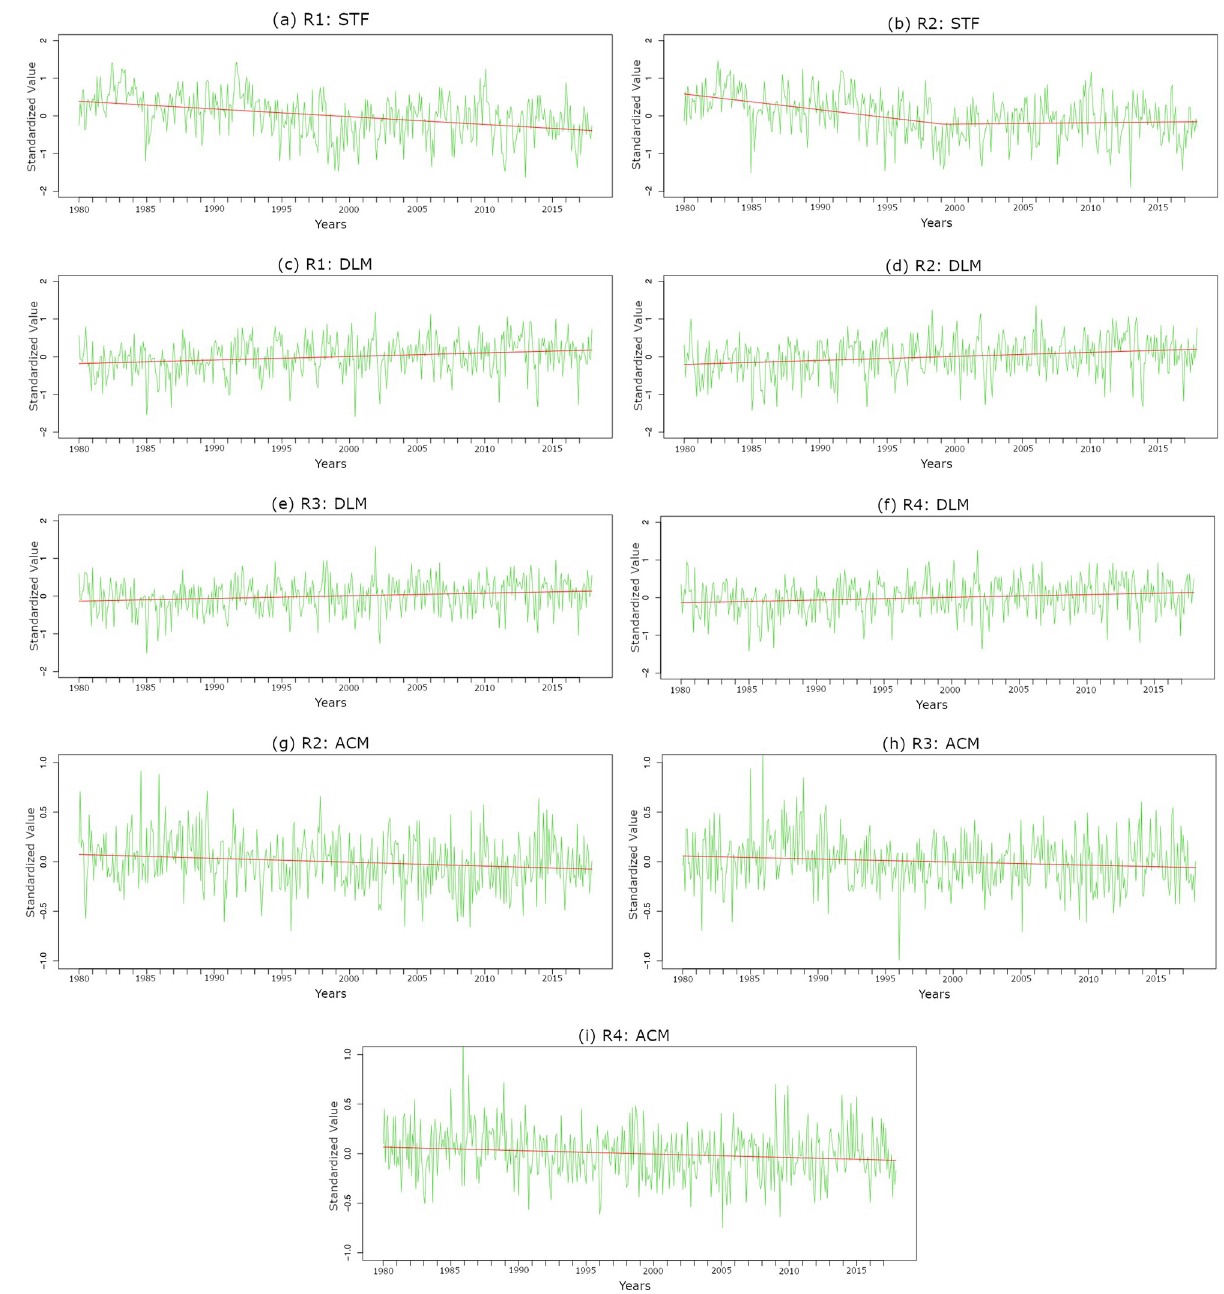
Fig 5. Monthly deseasonalized series for STF, DLM, and ACM from 1980 to 2017 with the red lines indicating the estimated trends for specific regions. Table 6 shows the estimated trends for the selected EOF modes for the four regions. (a) R1: STF, (b) R2: STF, (c) R1: DLM, (d) R2: DLM, (e) R3: DLM, (f) R4: DLM, (g) R2: ACM, (h) R3: ACM, and (i) R4: ACM. been observed in R1 then R2 with rates on average 54% and 46% respectively in the period from 2012 to 2014. For R3, the relative risk has been increasing with a lower rate compared to the southern regions (R1 and R2). That increase in the relative risk reaches a maximum of 15% in the period from 2003 to 2005. Finally, region R4 has the lowest rate of increase in the relative